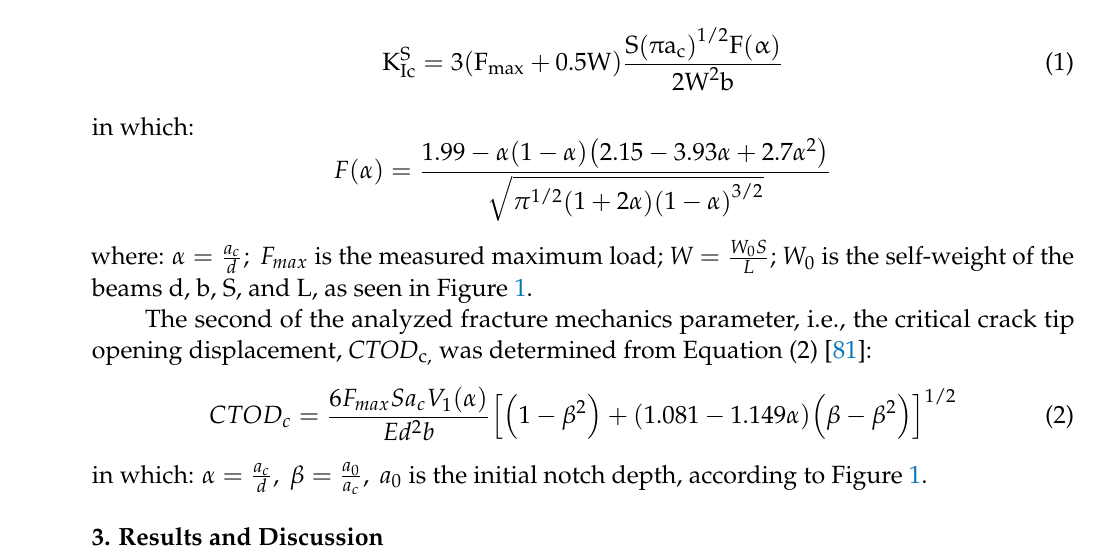
6 of 20 Figure 1. Three-point bending test setup: 1—specimen, 2—load, 3—clip gauge extensometer, 4— clamping test grips, 5—support, 6—initial crack.